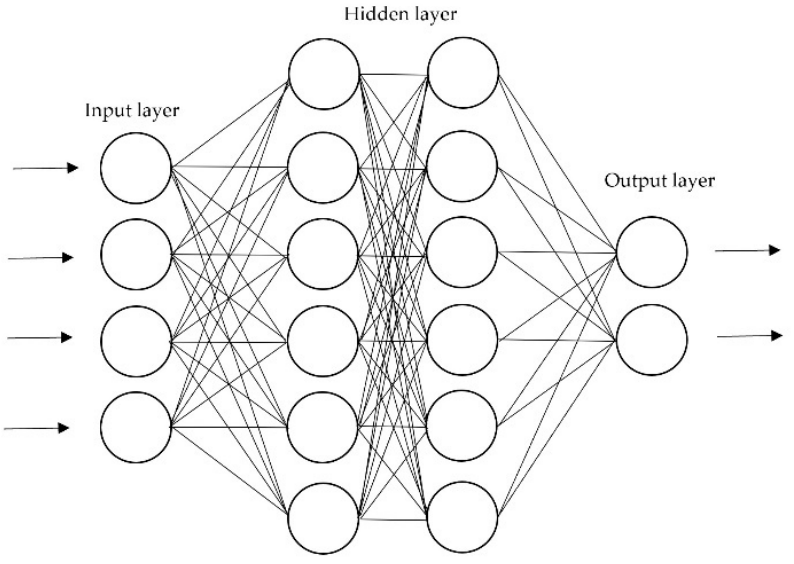
Figure 1. Typical structure of an artificial neural network (ANN) model.